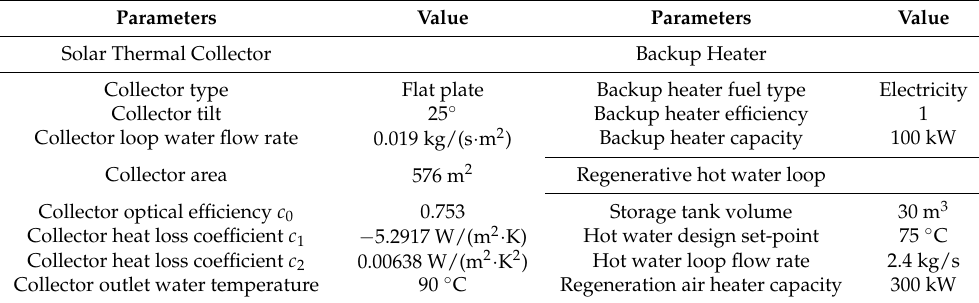
Table 4. Input parameters for the solar collector loop components simulation